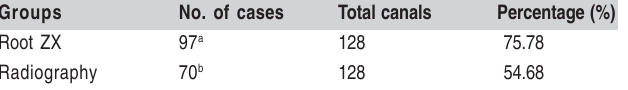
Different letters indicate statistically significant differences